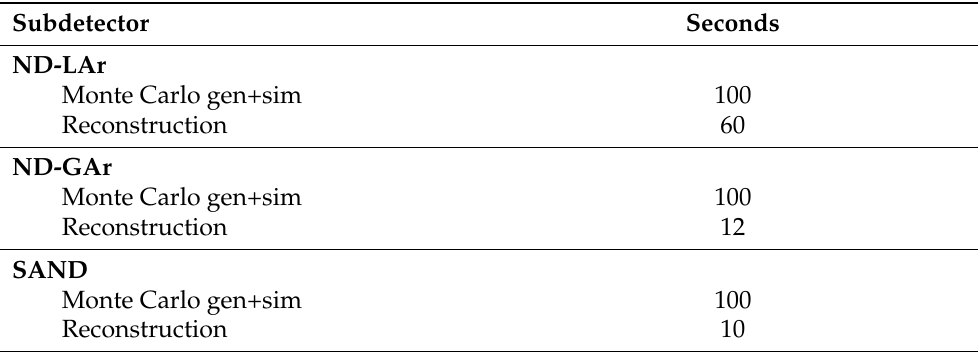
Table 30. CPU time to process one data event for the DUNE near detector components, in seconds, given mid-2020 reconstruction algorithms. These are rough estimates. Simulated events take more CPU time than data events due to the generation and simulation steps, overlay, and the handling of truth